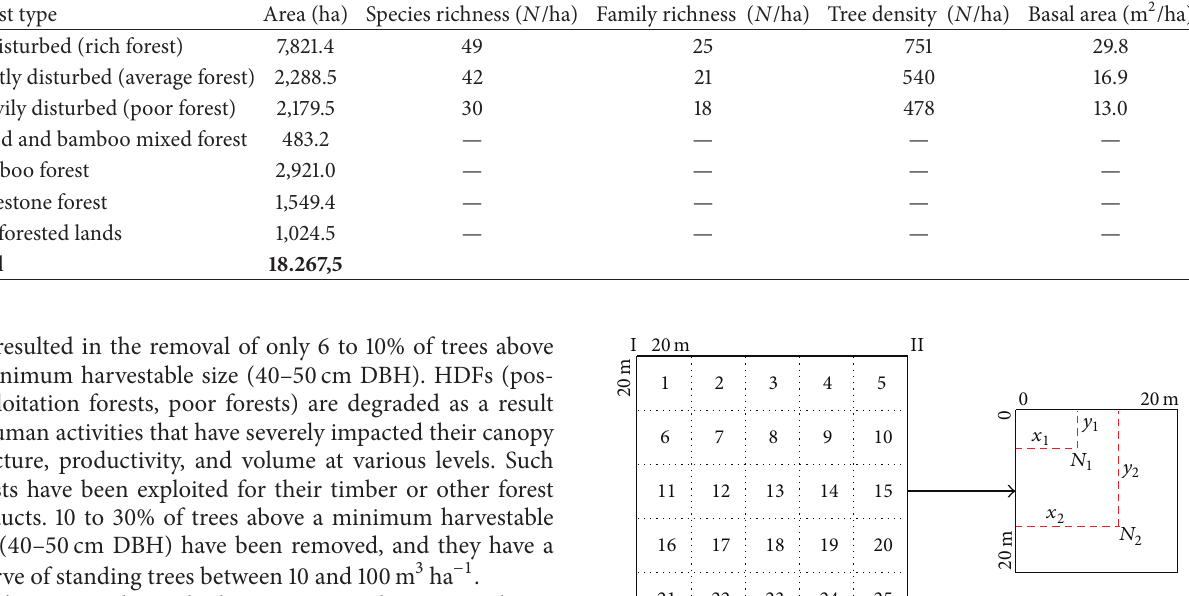
Table 1: Stratification of vegetation types and characteristics of three main forest types at Xuan Nha Nature Reserve, Vietnam. Forest type Undisturbed (rich forest) Lightly disturbed (average forest) 2,288.5